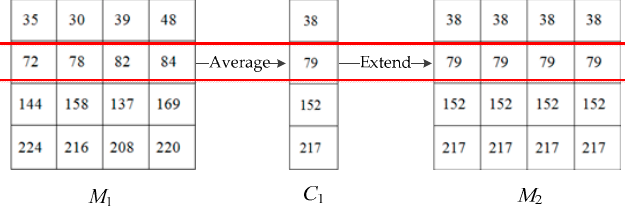
Figure 9. Diagram of the Grey Intensity Correcting Matrix (GICM) model. Every grey value is calculated using the mean value of each respective row.